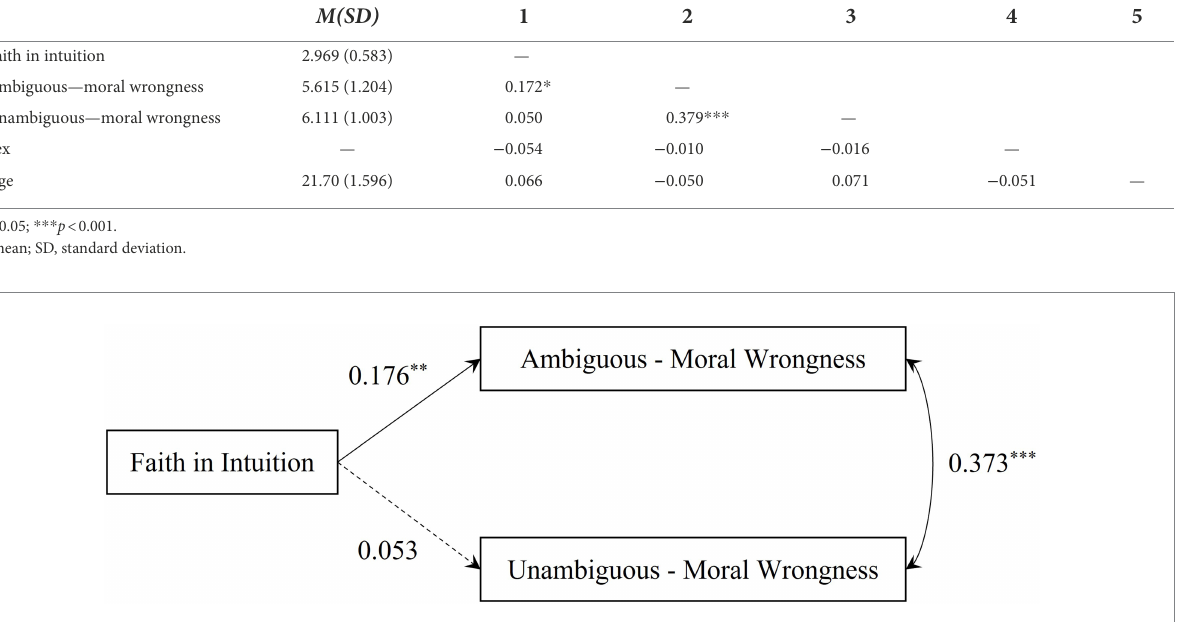
FIGURE 2 The model diagram of Experiment 1 (standardized results). ** p < 0.01, *** p < 0.001; dashed lines indicate non-significant